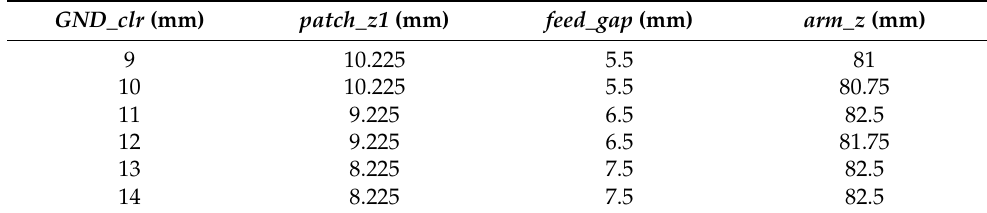
Table 3. Parameters that vary between IFAs.